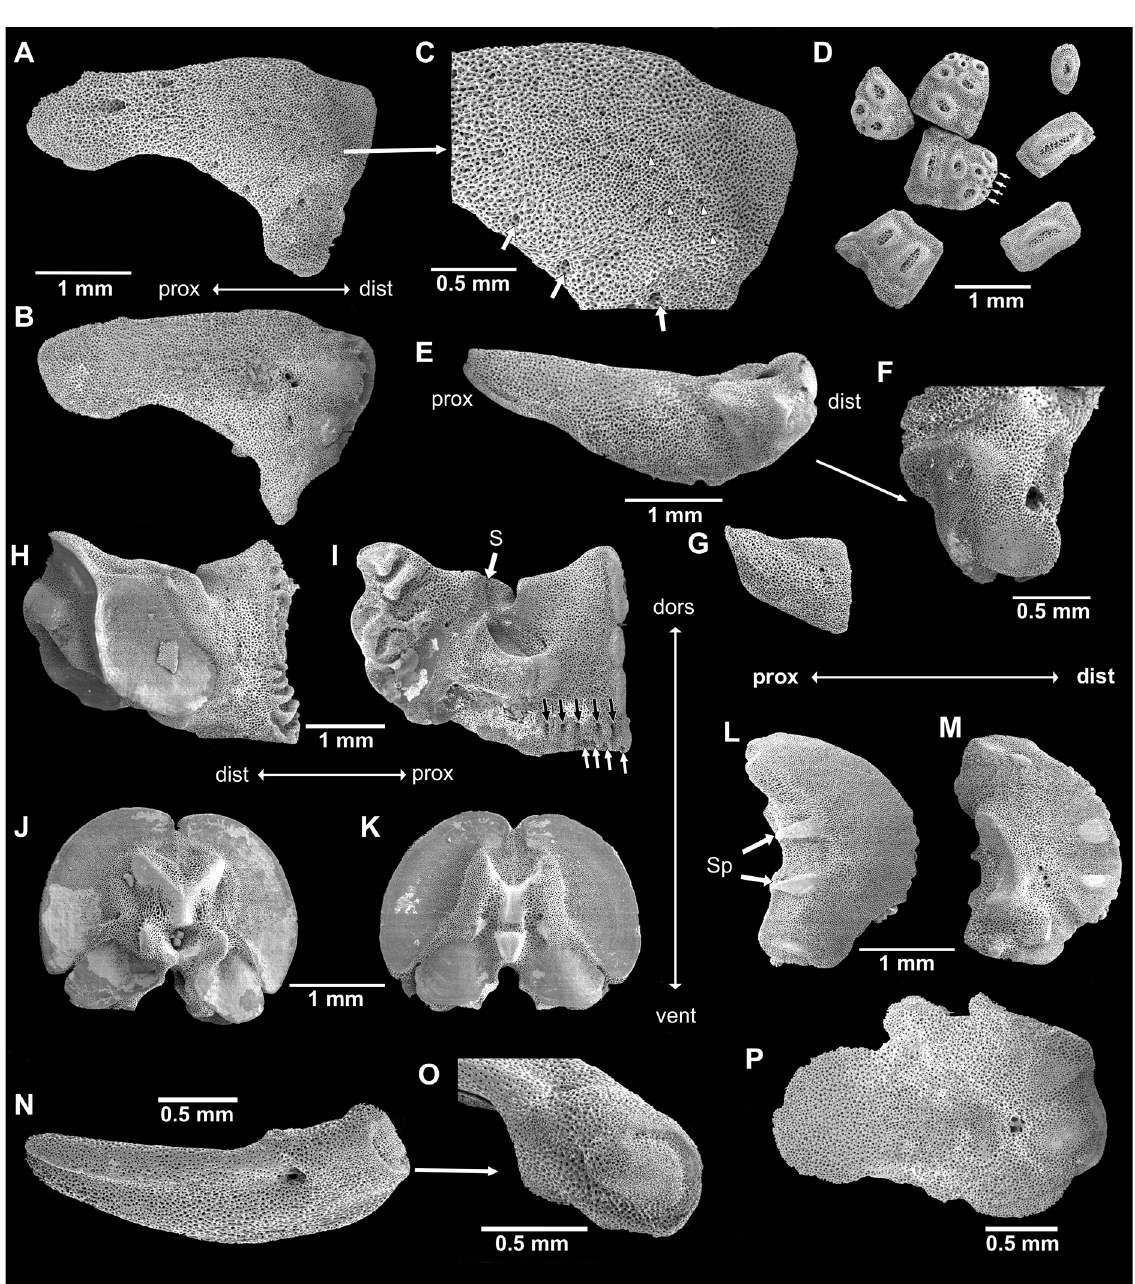
Fig. 3. SEM images of skeletal elements of Ophioderma longicauda (Bruzelius, 1805). A – M . Non-type specimen of 15.5 mm disc diameter (SMNH-160226). A . Radial shield, external aspect. B . Radial shield, internal aspect. C . Scale-free area of Fig. 3A magnified, white arrowheads point to granule sockets and pores, white arrows point to large peripheral pores. D . Dental plate fragments, arrows point to granule pores. E . Adradial genital plate. F . Articulation knobs of Fig. 3E. G . Abradial genital plate. H . Oral plate, abradial face. I . Oral plate, adradial face, black arrows point to oral papillae sockets and pores, white arrows point to granule socket pores. J . Arm vertebra, proximal face. K . Arm vertebra, distal face. L . Lateral arm plate, external face. M . Lateral arm plate, internal face. – N – P . Non-type specimen of 12 mm disc diameter (SMNH-133258). N . Adradial genital plate, lateral view. O . Adradial genital plate, distal end. P . Radial shield, internal aspect, note the different shape from Fig. 3A–B. Abbreviations: dist = distal; dors = dorsal; prox = proximal; S = suture line; Sp = spurs; vent =